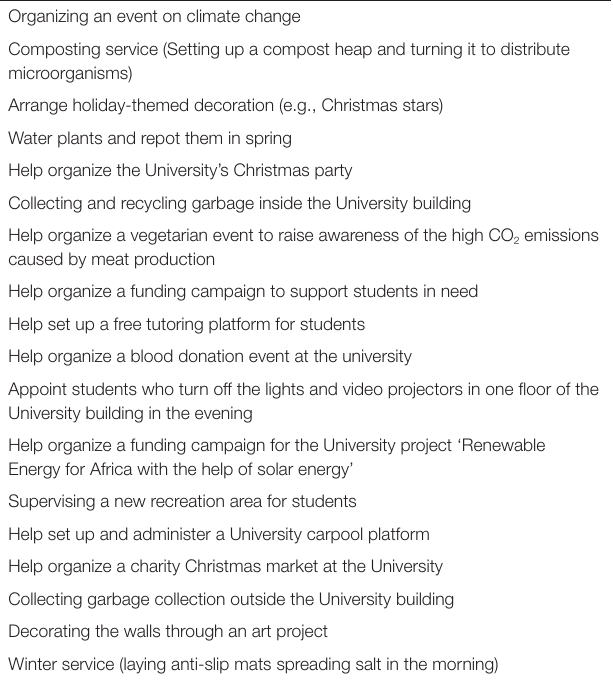
TABLE 3 | Items used in Study 2 to evaluate the planned University